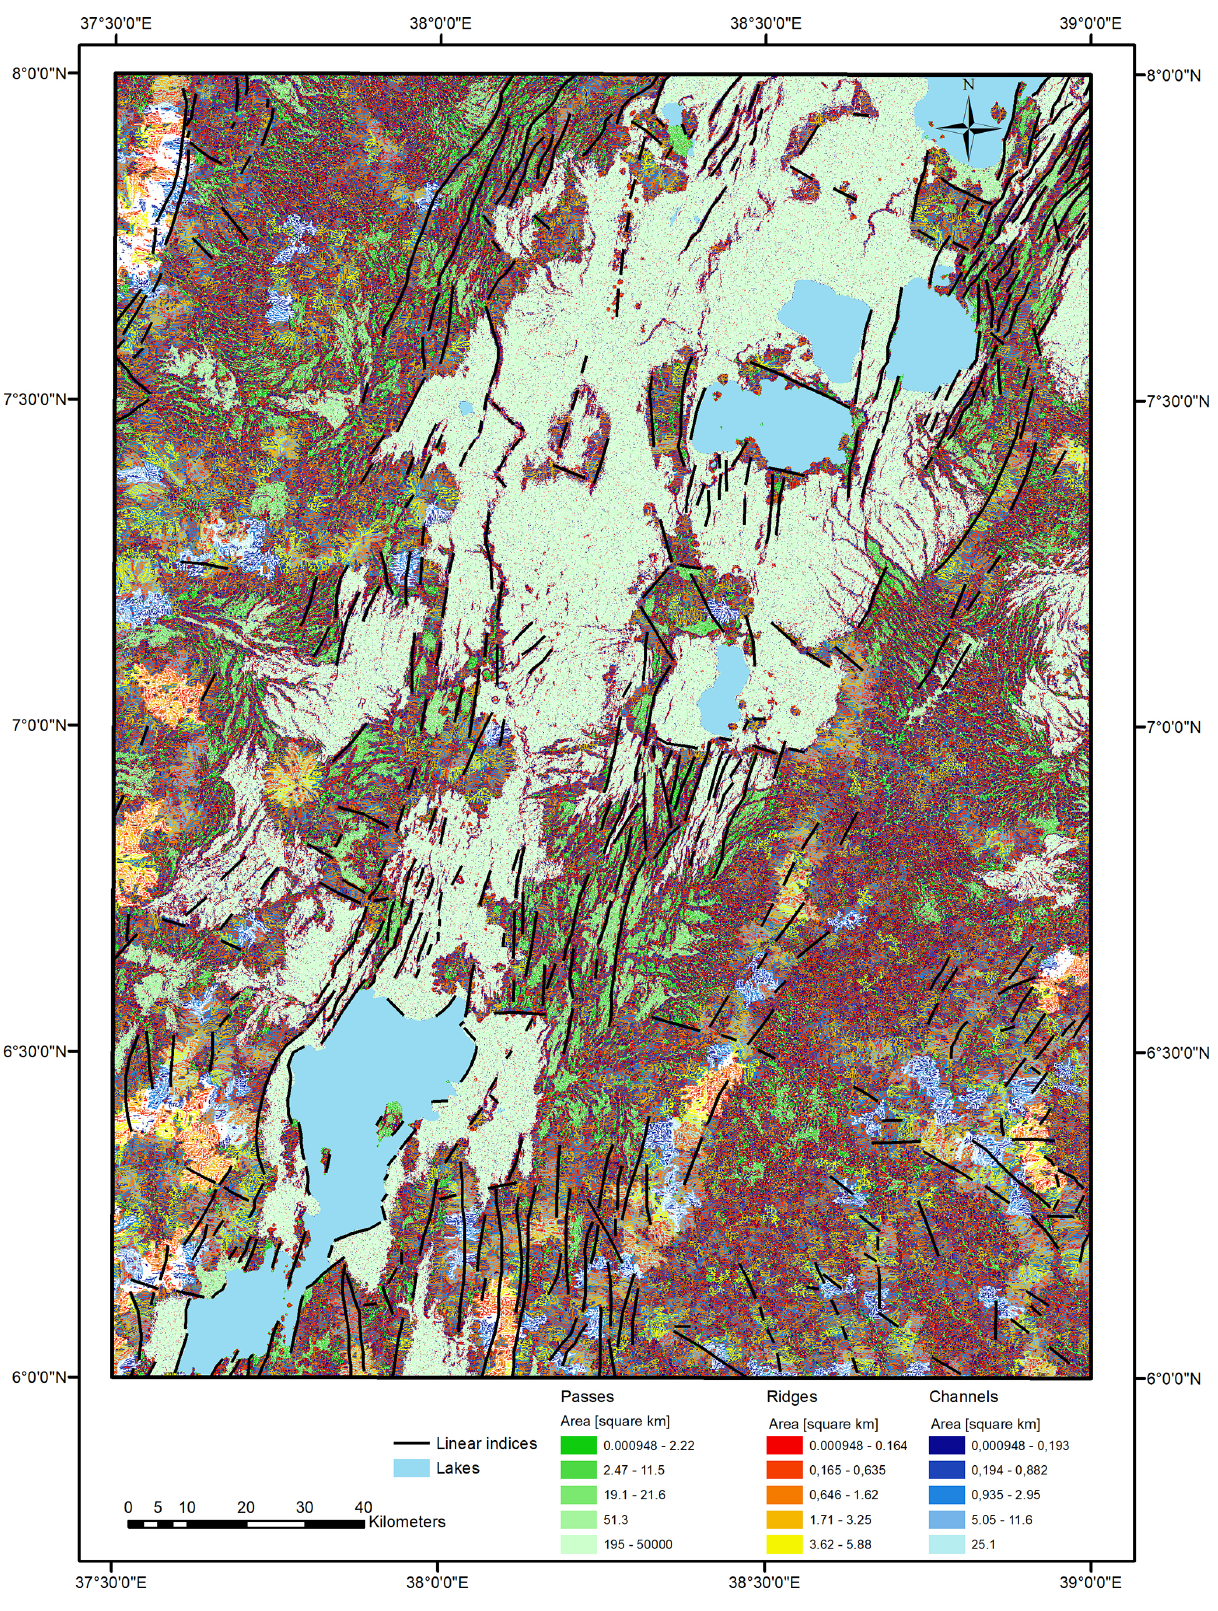
Figure 3. Morphotectonic analysis of the Dilla and Hossana areas based on morphometry. Linear indices show only the lines which are in accordance with both the visual interpretation of the DEM and the